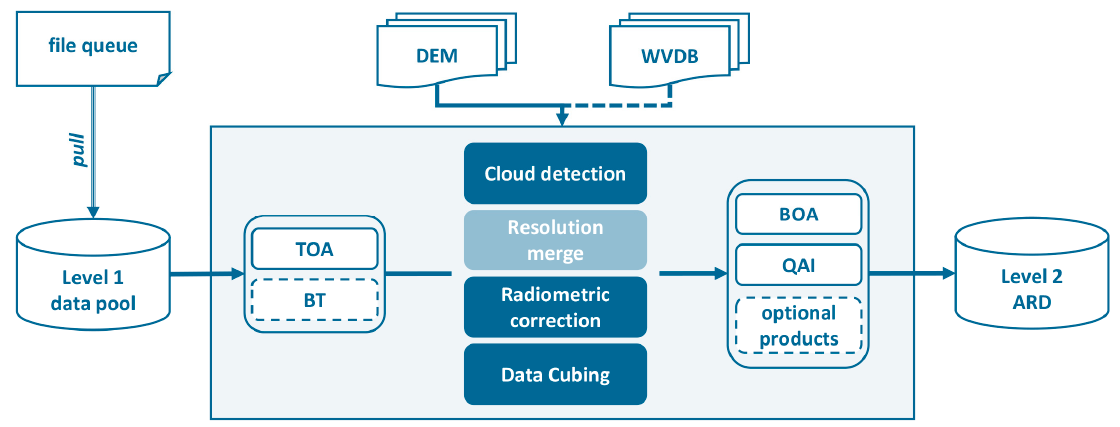
Figure 4. FORCE Level 2 Processing System (L2PS) workflow. TOA—top-of-atmosphere; BT—brightness temperature; BOA—bottom-of-atmosphere; QAI—quality assurance information.